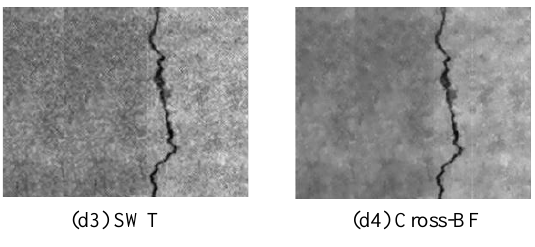
Figure 5. Filtered results by BF, SWT and